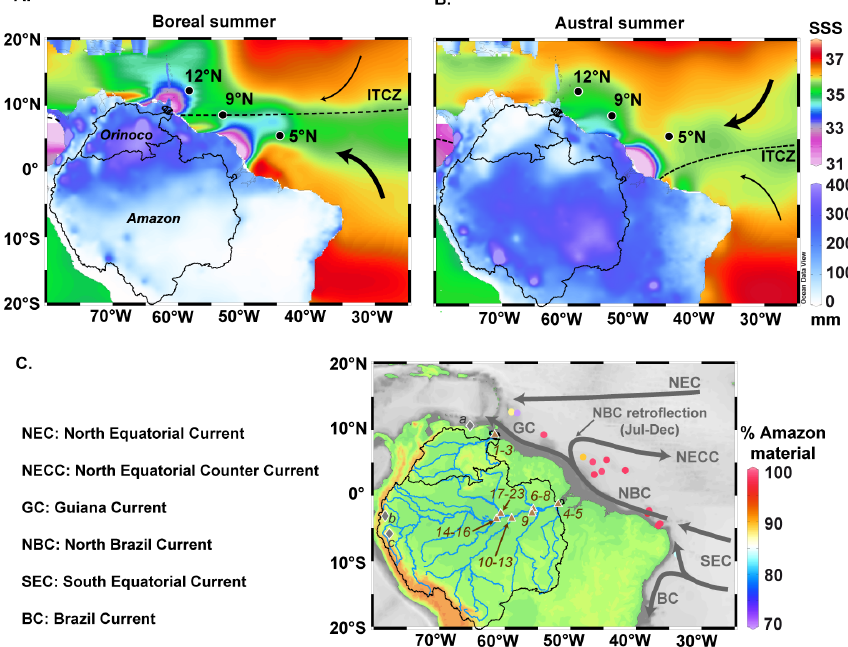
Fig. 1. Regional setting. Mean 1950–1999 terrestrial precipitation from the University of Delaware (http://climate.geog.udel.edu/~climate/) and mean sea surface salinity (SSS) from the World Ocean Atlas 2009 (Antonov et al., 2010) for (A) boreal summer (June–August for precipitation, September for SSS) and (B) austral summer (December–February for precipitation, March for SSS). The characteristic position of the intertropical convergence zone (ITCZ), and Orinoco and Amazon watersheds are shown. Black arrows illustrate the strength of the SE (strong in boreal summer, in A and NE (strong in austral summer, in B ) trade winds. Black dots mark the location of the studied sediment cores: GeoB3938-1 at 12 ◦ N, GeoB7010-2/GeoB7011-1 at 9 ◦ N and GeoB4411-2 at 5 ◦ N (Table 1). (C) Topography and bathymetry map. The main surface ocean currents are shown (Rühlemann et al., 2001). Coloured dots show the proportion of Amazon material within the terrigenous fraction (see Sect. 3.5) in surface sediment samples (Govin et al., 2012). Brown triangles show the position of river suspended samples used to define the elemental composition of endmembers (numbers refer to Table S3 in the Supplement). Grey diamonds show the location of published records: (a) Cariaco Basin (Peterson et al., 2000), (b) Santiago cave (Mosblech et al., 2012), (c) Cueva del Diamante cave (Cheng et al., 2013). Botuverá cave (Cruz et al., 2005) is located further to the south (27 ◦